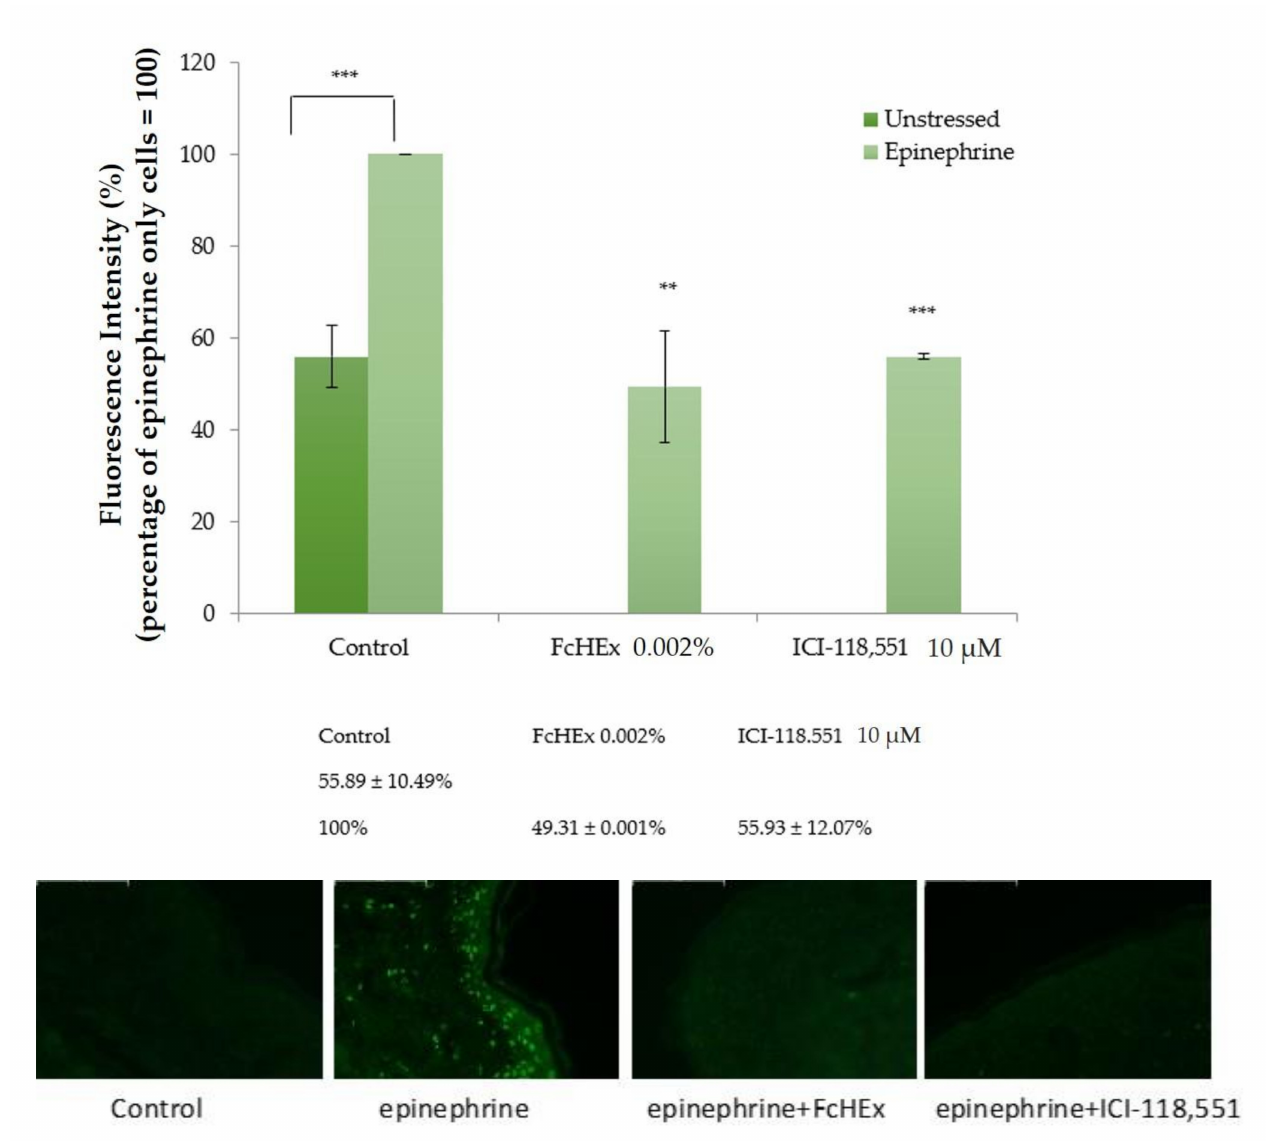
Figure 5. Effect of the FcHEx on the protein carbonylation in the human skin explants. Human skin punches, which were derived from aesthetic surgical biopsies, were treated with the FcHEx or the positive control in the presence of 56 nM of epinephrine. The reported values represent the averages of three independent experiments and are expressed as the percentages of skin explants treated with epinephrine only, which was set to 100%. The asterisks indicate statistically significant values (*** p -value was between 0.0001 and 0.001; ** p -value was between 0.001 and